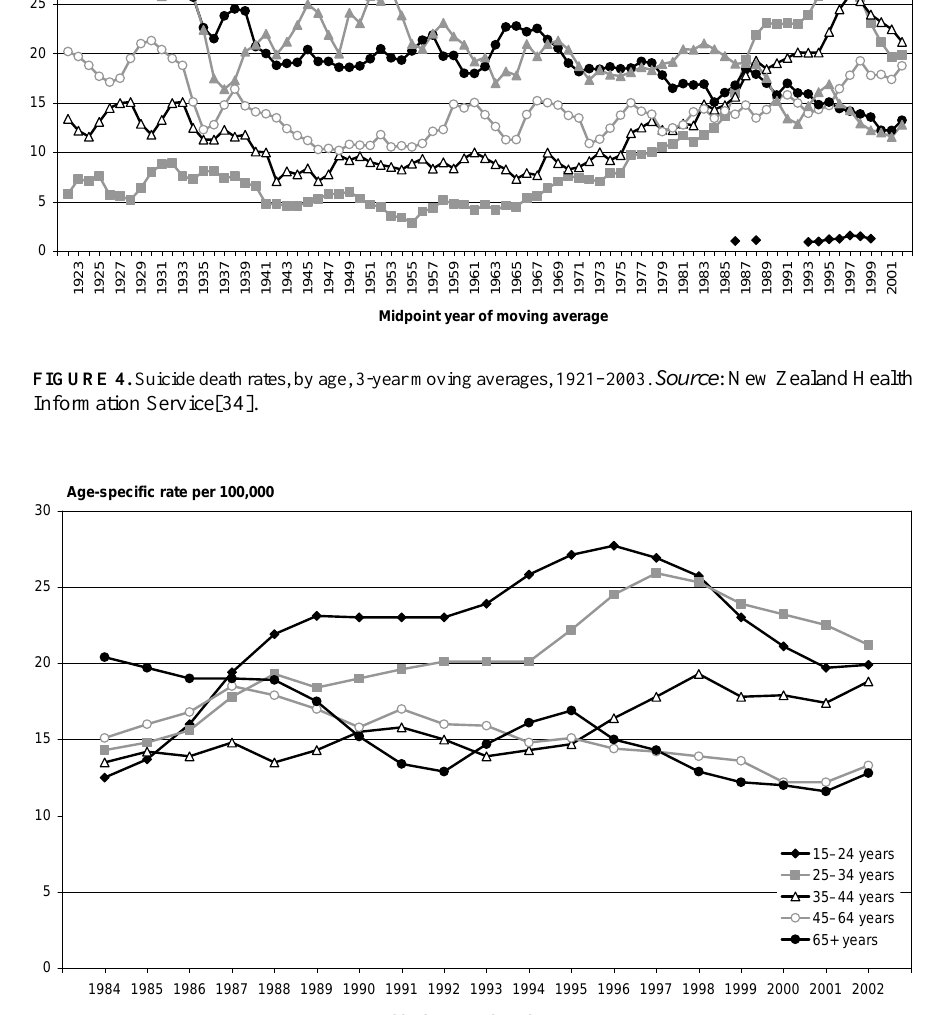
FIGURE 5. Suicide death rates, by age, 3-year moving averages, 1983–2003. Source : New Zealand Health Information